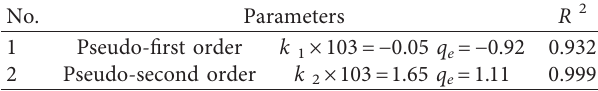
Figure 11: Pseudo-first order for adsorption of brilliant green dye onto AC. Table 2: Kinetic parameters for the adsorption of BG onto AC.